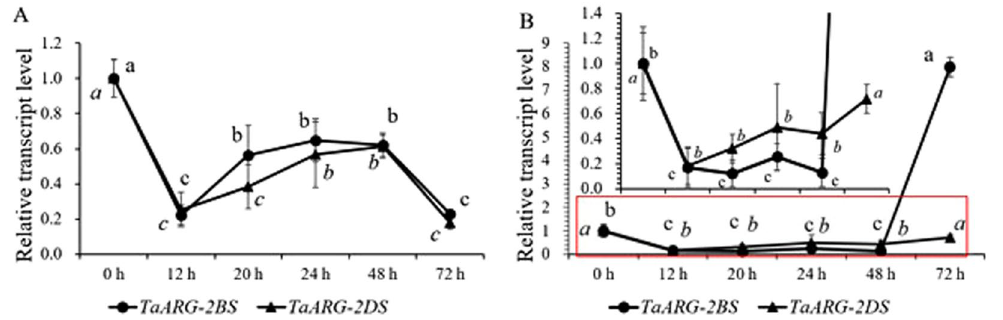
Figure 8. Transcript levels of TaARG genes in wheat leaves under inoculation of powdery mildew. ( A ) Pm97033; ( B ) Wan7107. Each data point is an average of three biological repeats (mean ± SD). Small letters in bold or italic represent significant differences between TaARG-2BS and TaARG-2DS at α < 0.05 using Duncan’s multiple range test. The highlighted part on the top in Fig. 8B was its partial graph in red rectangle.